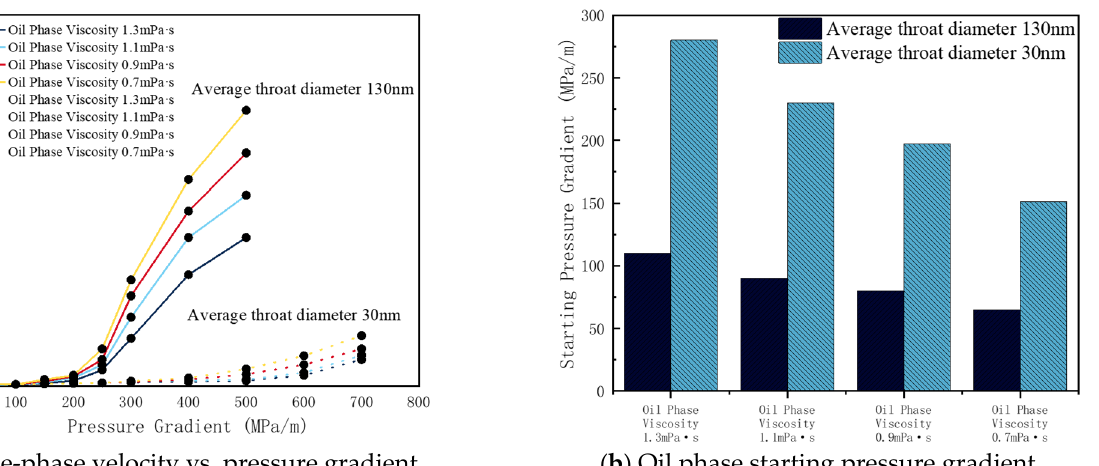
Figure 21. Fluid pressure diagram under different oil phase viscosities. It can be seen from Figure 22 that when the viscosity of the oil phase increases, the oil-flow area decreases, and the pressure in large-size pores decreases. The increasing oil viscosity makes it more difficult to flow in the pores.